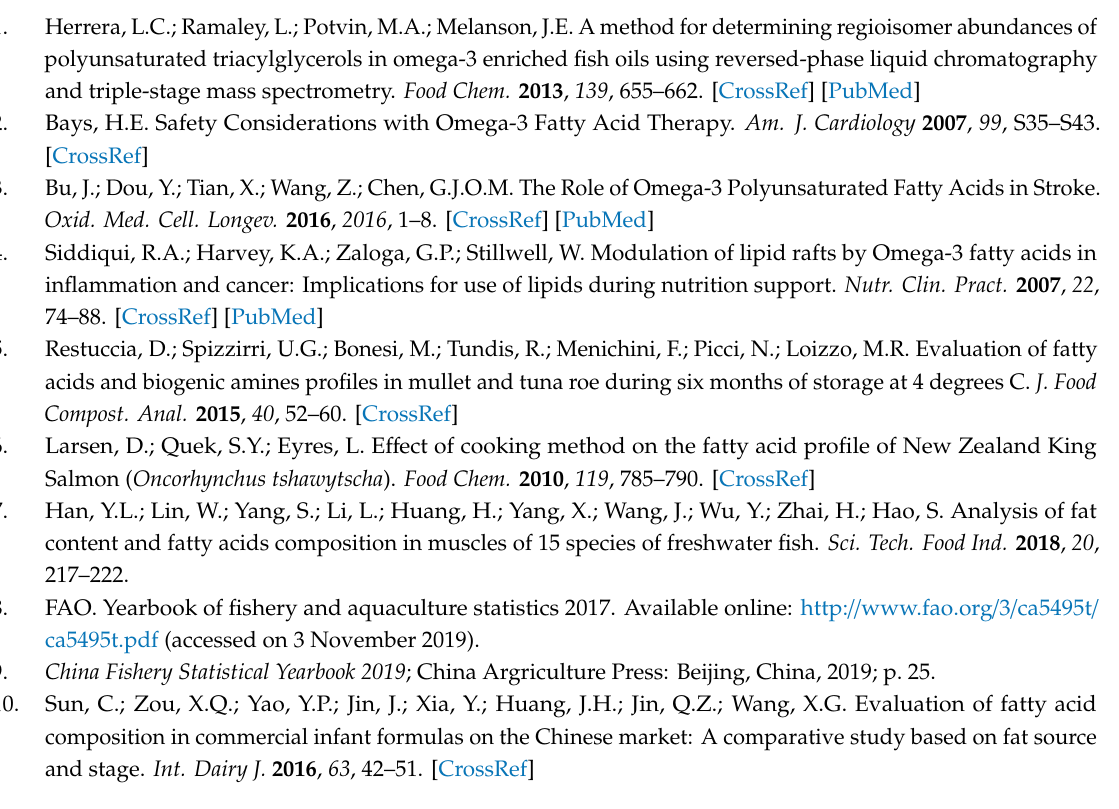
Supplementary Materials: The following are available online at. Table S1: Fatty acids profiles of three kinds of fish heads; Table S2: Fatty acids profiles of di ff erent lipids classes in big eye tuna head; Table S3: Composition and contents of triglycerides in big eye tuna, Atlantic salmon and bighead carp heads; Figure S1: (A) Calibration curve of TG from big eye tuna head using TG (18: / 18:1 / 18:0) as external standard and TG (16:0 / 18:0 / 16:0)-d5 as the internal standard, a total of 13 points were prepared to cover the peak area ratio of internal standard and external standard, injection volume is 1 µ L. (B) Calibration curve of TG from Atlantic salmon and bighead carp heads using TG (18: / 18:1 / 18:0) as external standard and TG (16:0 / 18:0 / 16:0)-d5 as the internal standard, a total of 13 points were prepared to cover the peak area ratio of internal standard and external standard, injection volume is 1 µ